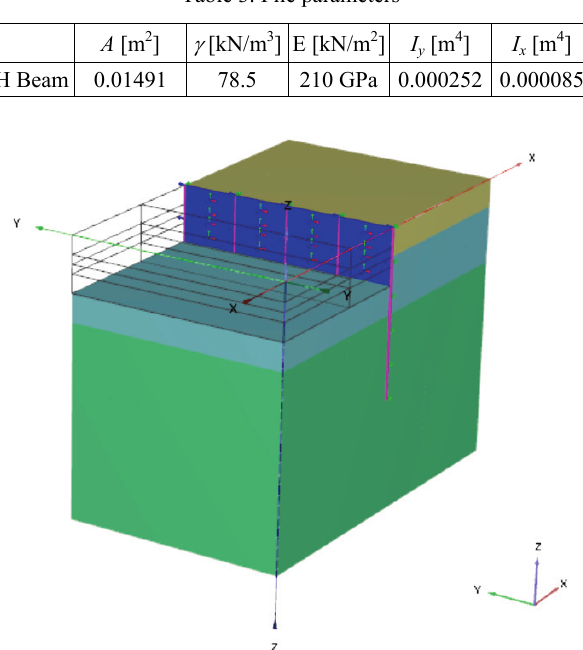
Fig. 7. Computational model